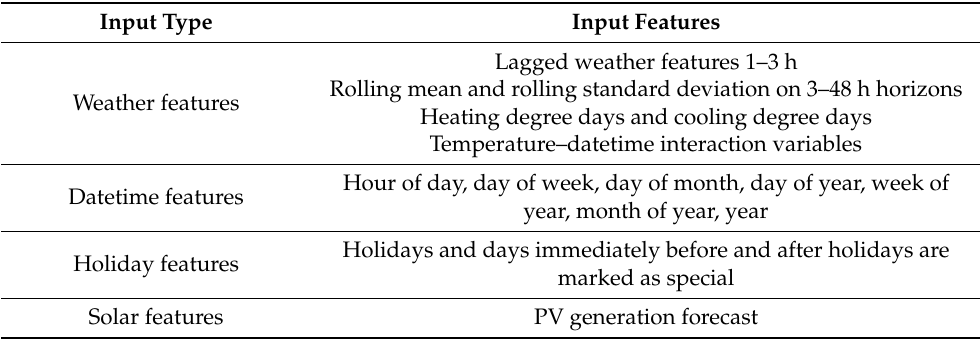
Table 1. Input features used in demand